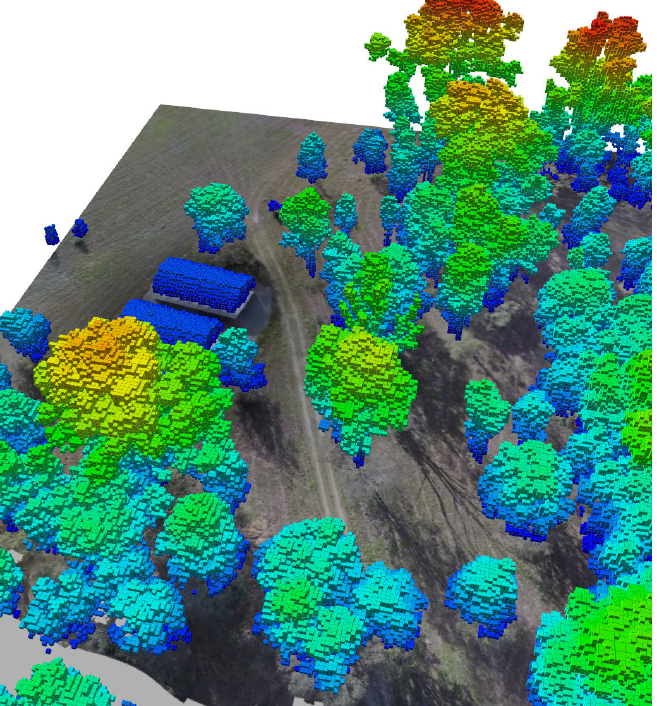
Figure 9. Three-dimensional (3D) occupancy map from the Hovermap LiDAR data of The Samford Ecological Research Facility (SERF). Occupied cells represent the physical location of various tree species and greenhouses present at